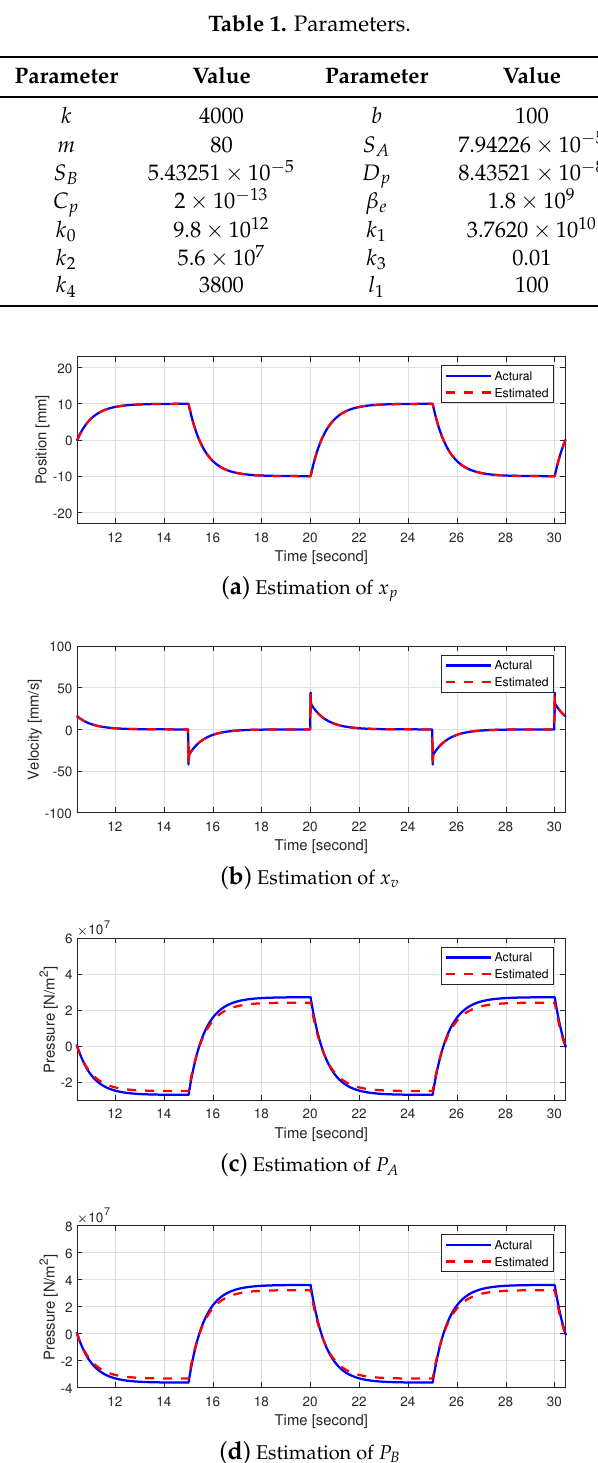
Figure 3. Estimation results of the proposed state observer in simulations with the trajectory